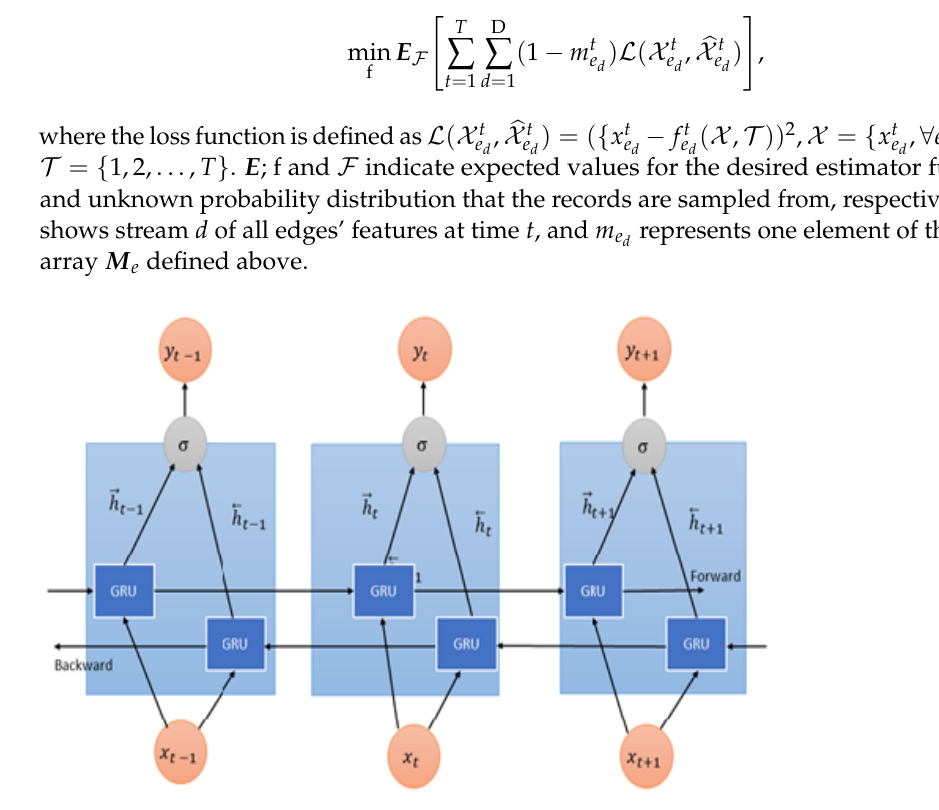
Figure 3. Bi-directional gated recurrent